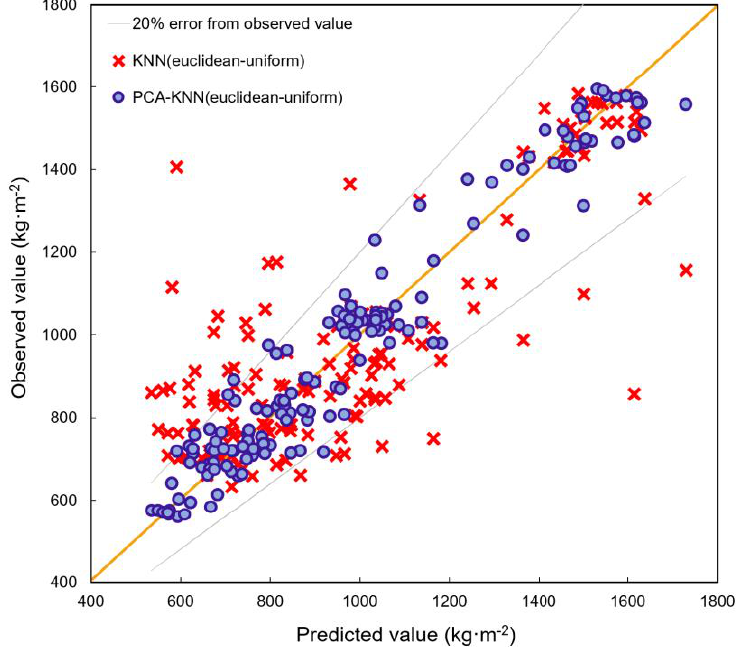
Figure 7. Observed and predicted demolition-waste-generation rate values, comparing the KNN (Euclidean uniform) and PCA − KNN (Euclidean uniform) models. Gray lines: ±20% error on the observed values.